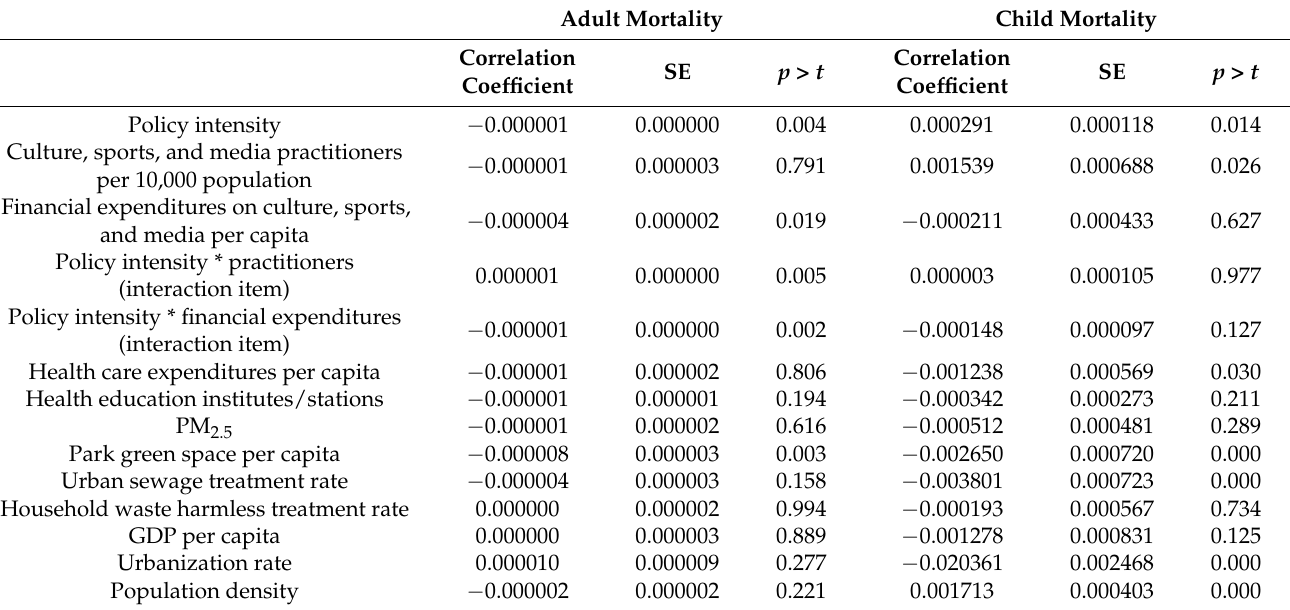
Table 3. Regression results of equation.